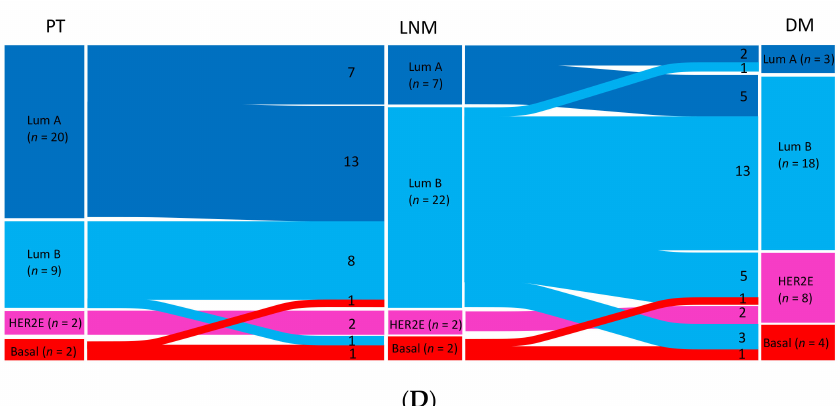
Figure 2. ( A – D ): Sankey diagrams showing the PAM50 breast cancer intrinsic subtype shifts of matched samples between ( A ) the primary tumor (PT) and lymph node metastasis (LNM) ( n = 59); ( B ) the PT and distant metastasis (DM) ( n = 61); ( C ) LNM and DM ( n = 38); and ( D ) the PT, LNM, and DM ( n = 33). Abbreviations: HER2-E: human epidermal growth factor receptor 2-enriched; Lum A/B: luminal